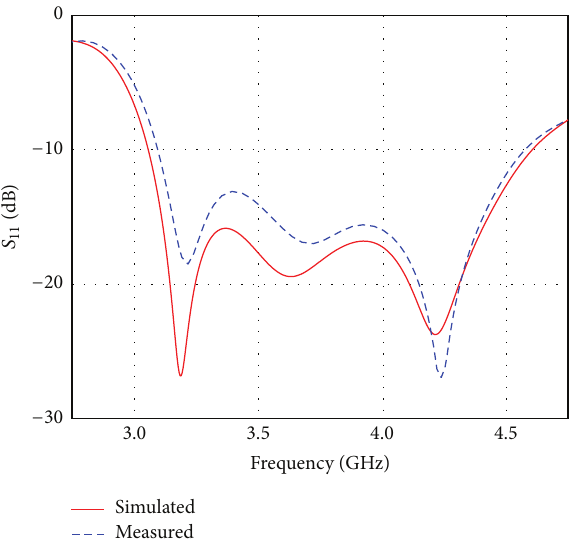
Figure 8: Measured and simulated |𝑆 11 | .